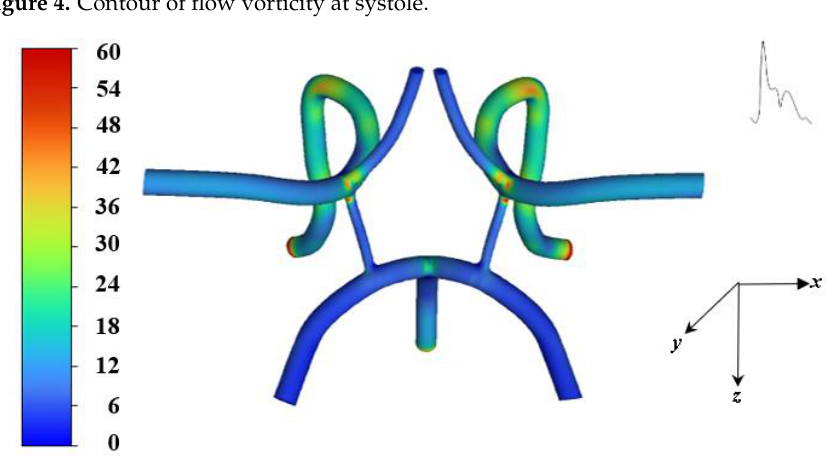
Figure 5. Contour of wall shear stress at systole.